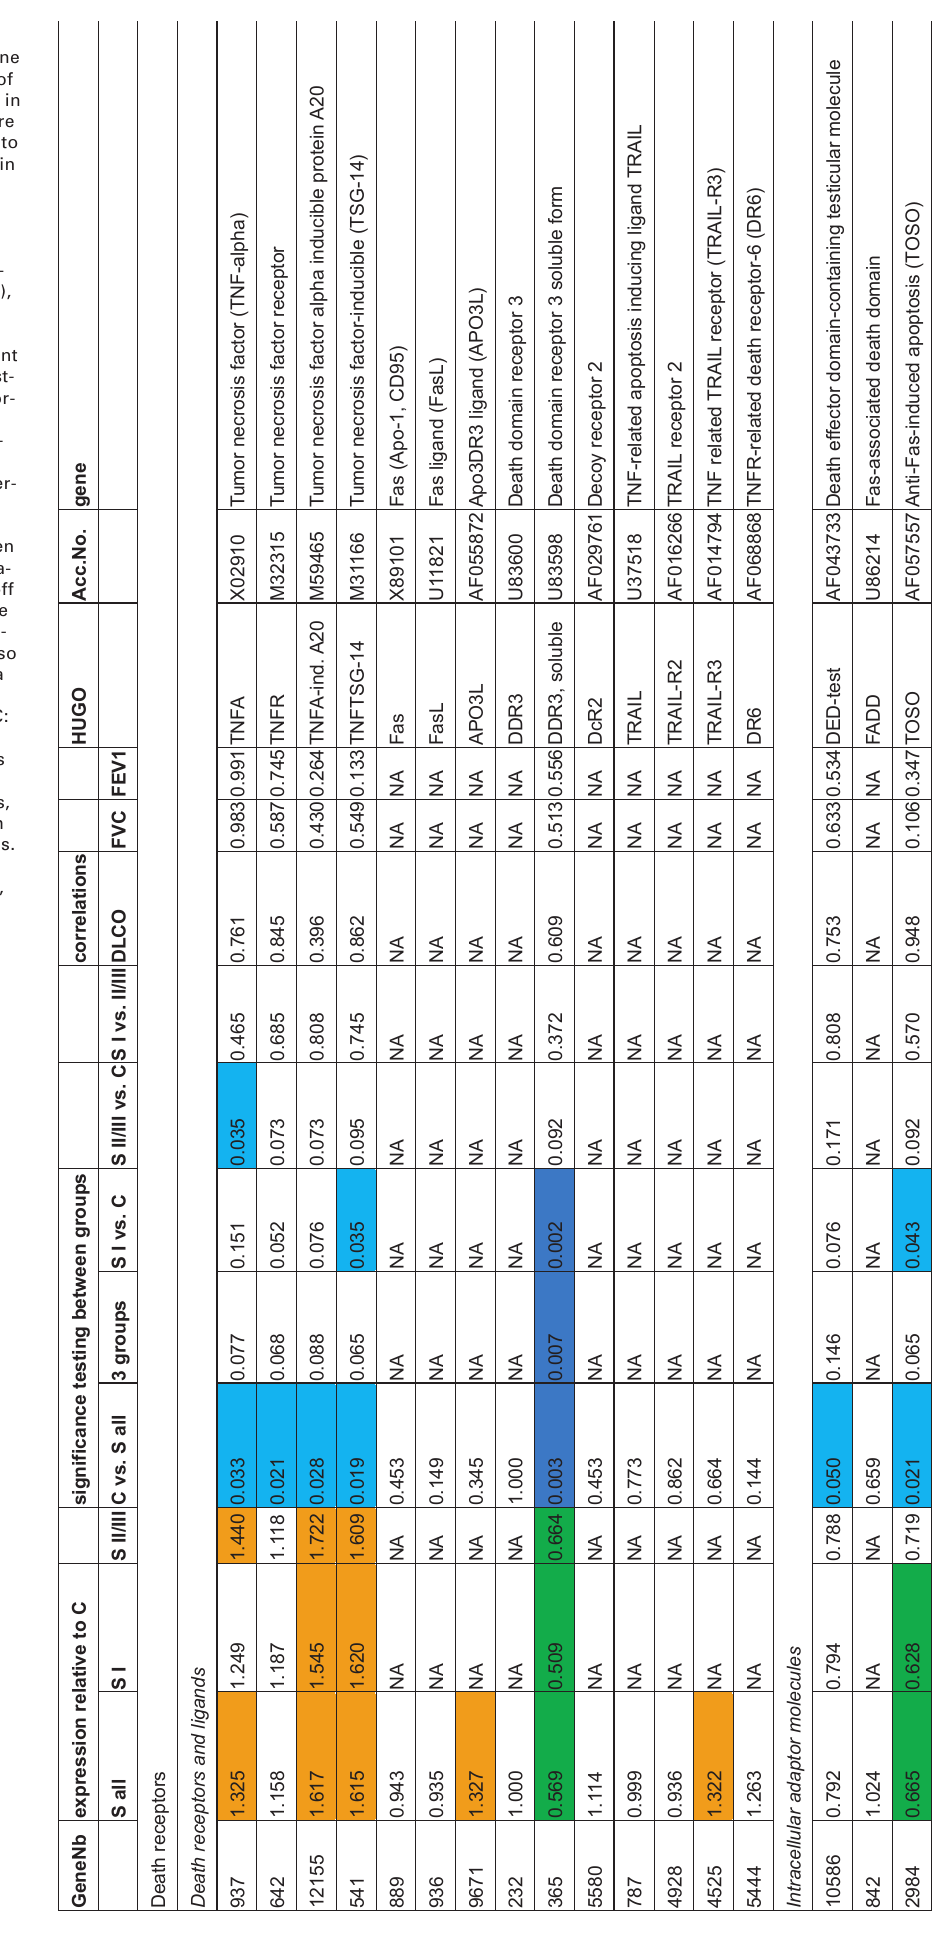
Summary of the gene expression results of 112 genes involved in apoptosis. Genes are grouped according to function and listed in alphabetical order. The table gives be- sides the gene ex- pression levels (re-